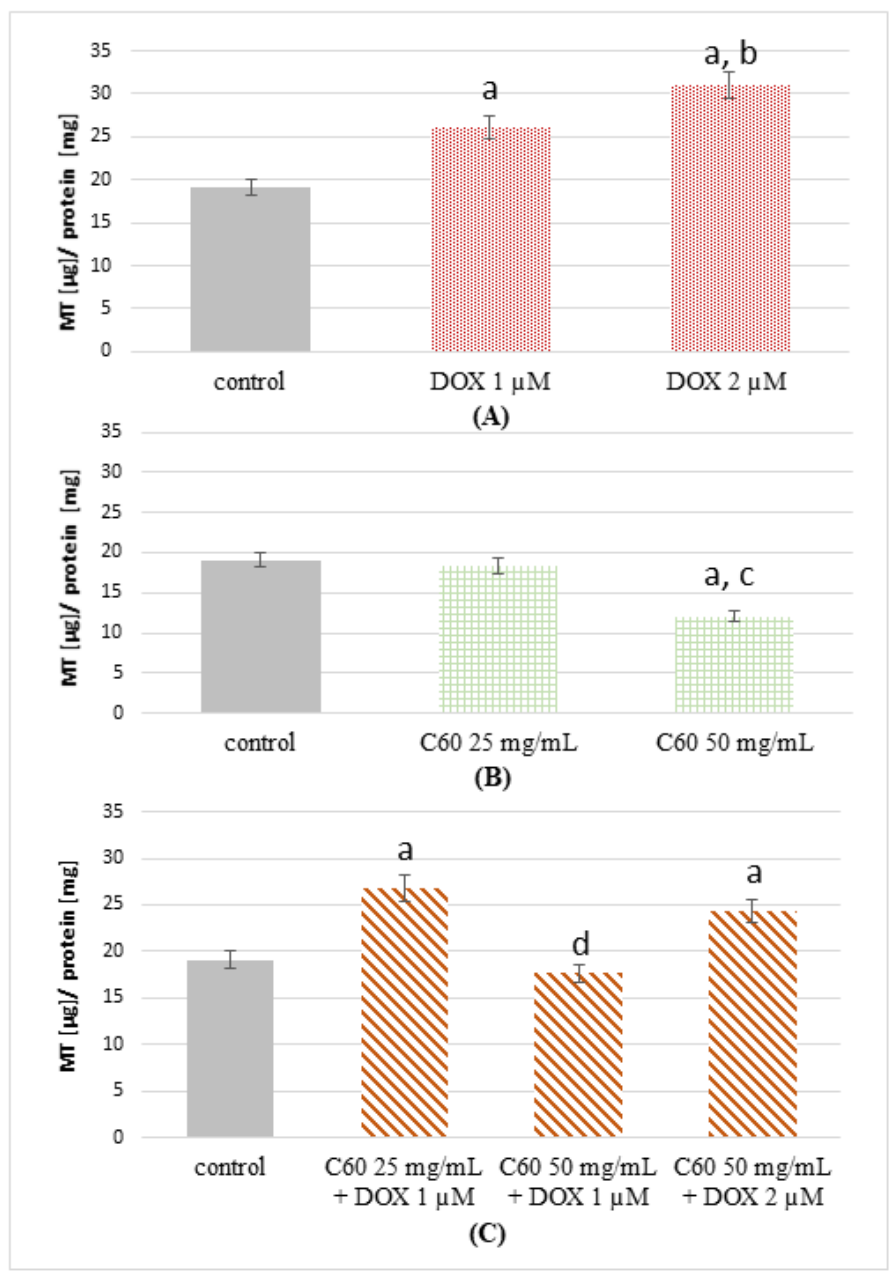
Figure 3. Concentration of metallothionein (MT) in MCF-7 cells treated by DOX, C 60 and C 60 –DOX complexes. Concentration of MT-1/2 in MCF-7 cells treated by ( A ) DOX, ( B ) C 60 , ( C ) complexes of C 60 – DOX. For other experimental conditions, see Material and Methods. a p < 0.05 when compared to control cells; b p < 0.05 when compared to cells treated by 1 µM DOX; c p < 0.05 when compared to cells treated by 25 mg/mL C 60 ; d p < 0.05 when compared to cells treated by C 60 –DOX complexes (25 mg/mL C 60 -1 µM DOX and 50 mg/mL C 60 -2 µM DOX).